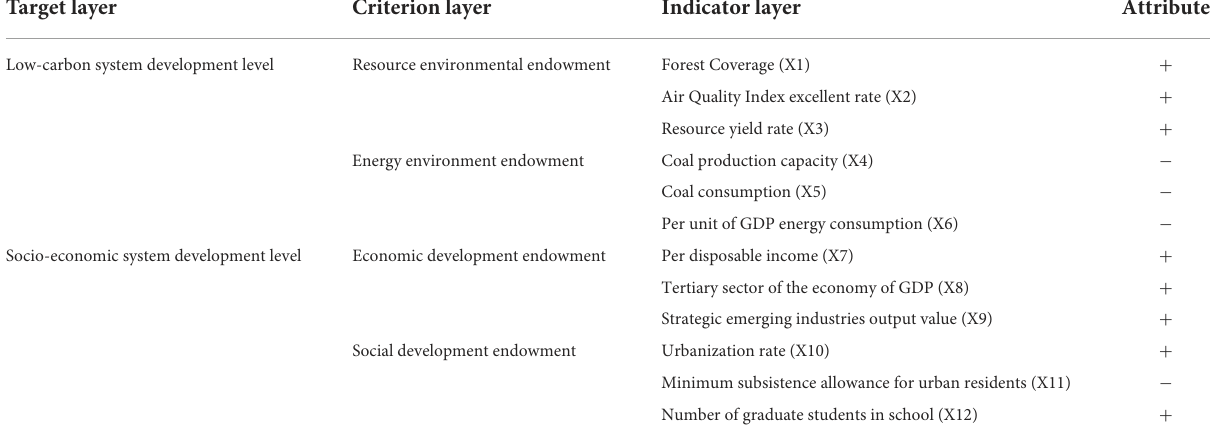
TABLE 1 Comprehensive indicator evaluation